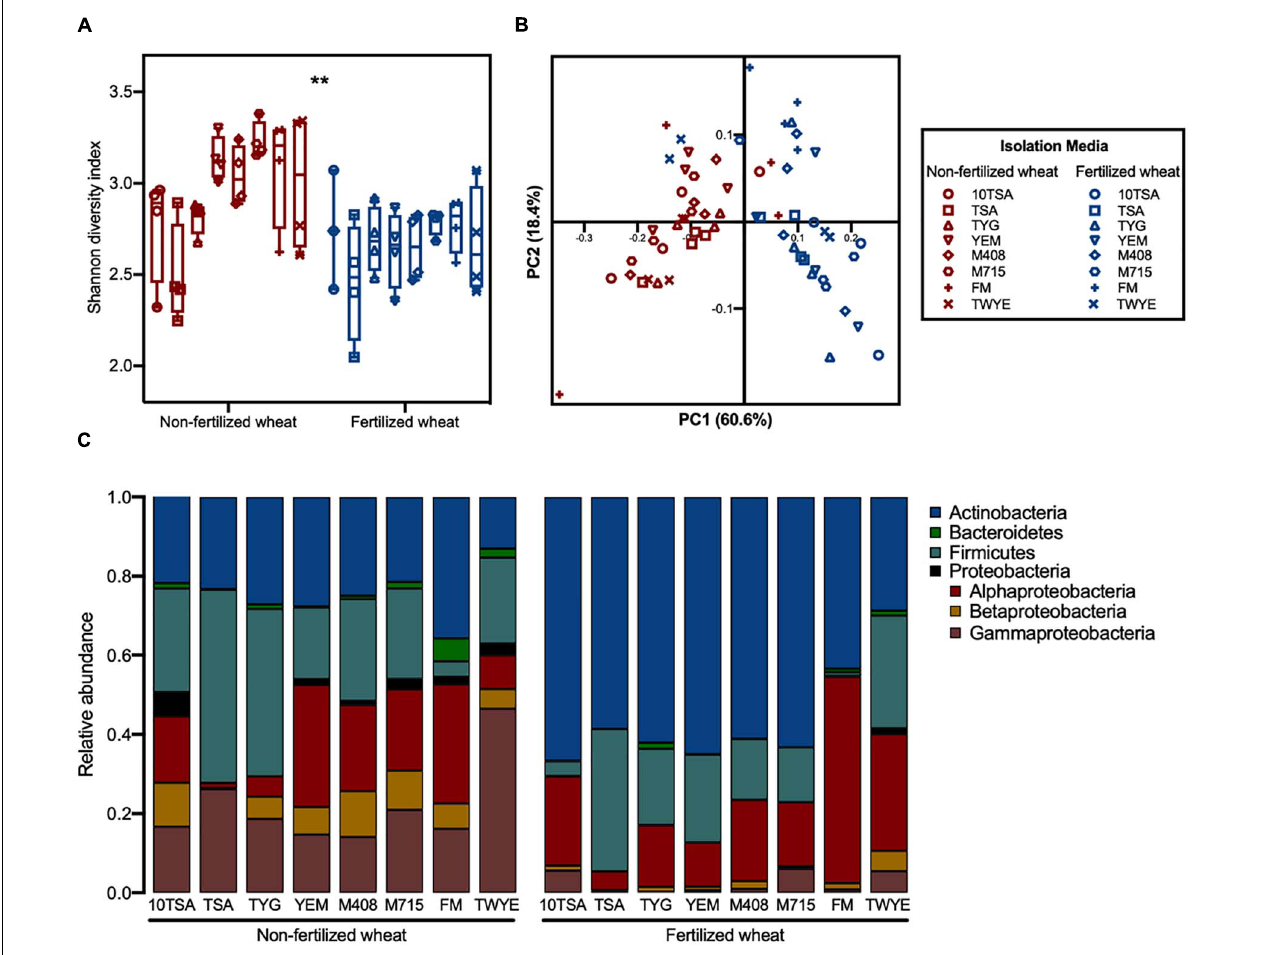
FIGURE 3 | Influence of different culture-agar on bacterial community diversity and structure in the rhizosphere of wheat grown in soils with and without fertilizer. (A) Alpha diversity estimates at ASV level for rhizosphere bacterial communities grown on eight agar types with median (line) and hinges at first and third quartiles (25th and 75th percentiles). Significant differences as determined by two-way type III ANOVA are shown by “**” for p < 0.01 between treatment groups. (B) PCoA plot of bacterial community composition based on weighted UniFrac distances at ASV level, colored by fertilizer treatment. Symbols represent the isolation media that bacteria were cultured on from rhizosphere samples: TSA (10th concentration) (circles), TSA (squares), TYG (up-triangles), YEM (down-triangles), M408 (diamond), M715 (hexagon), FM (plus), TWYE (cross). (C) Average relative abundances of bacterial phyla within the bacterial 16S V3–V4 sequences. Identifications are based on the SILVA database for